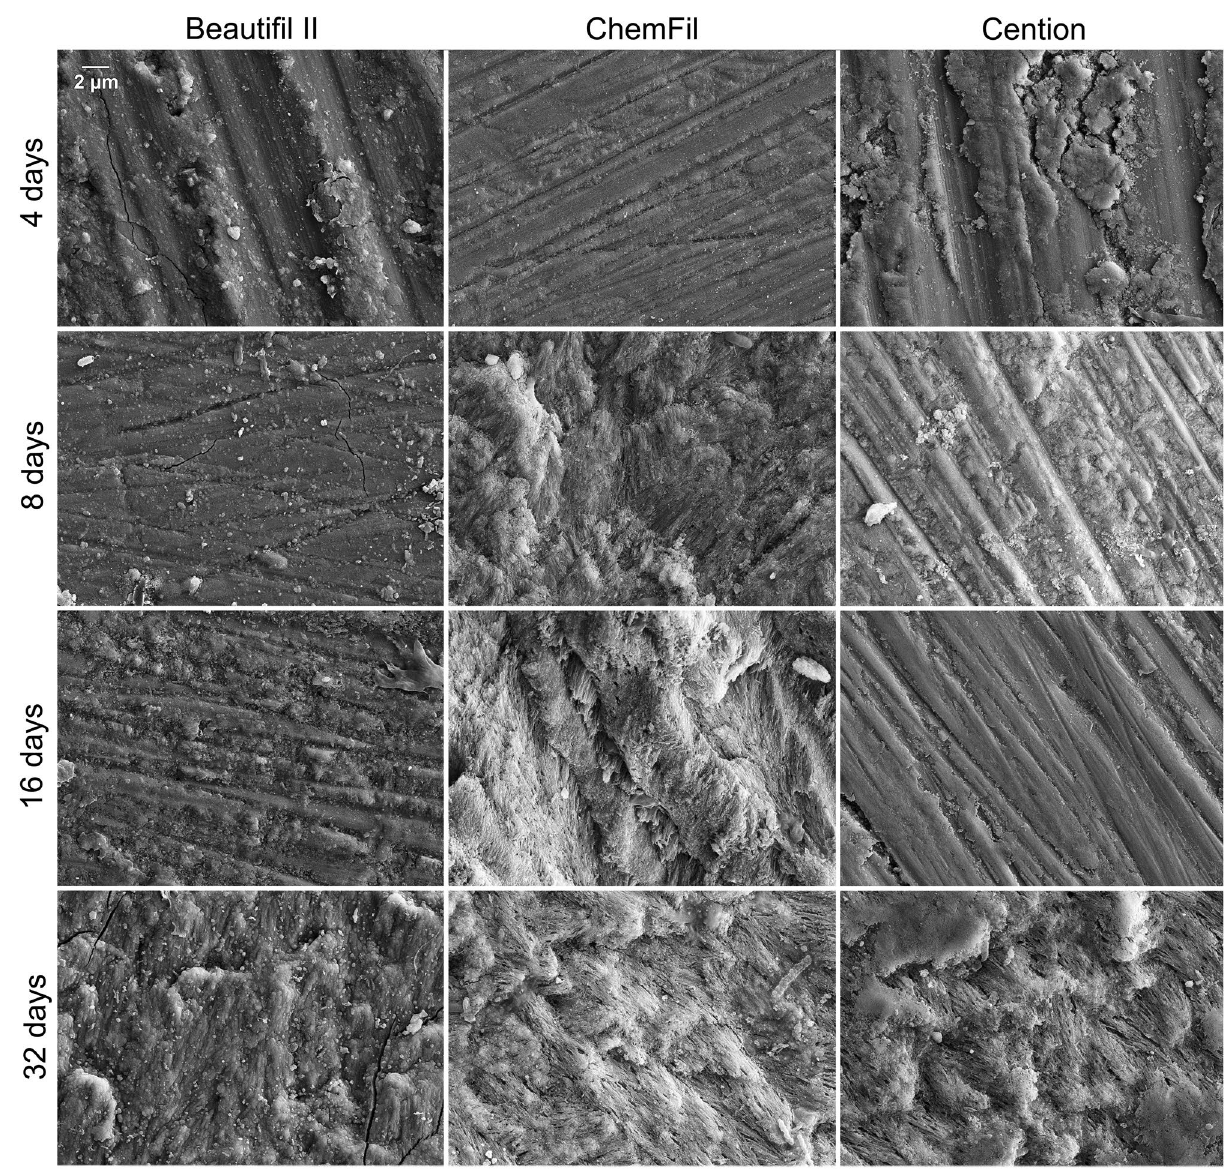
Figure 5. Scanning electron microscopy images of the surfaces of enamel blocks immersed with commercial reference